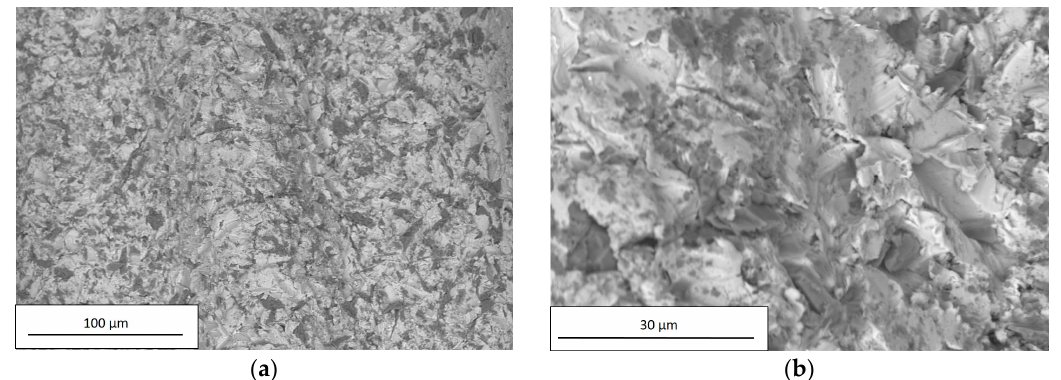
Figure 9. SEM observation of B, acquired using a Hitachi TM3000 with a magnification of ( a ) 250× and ( b ) 2500×.